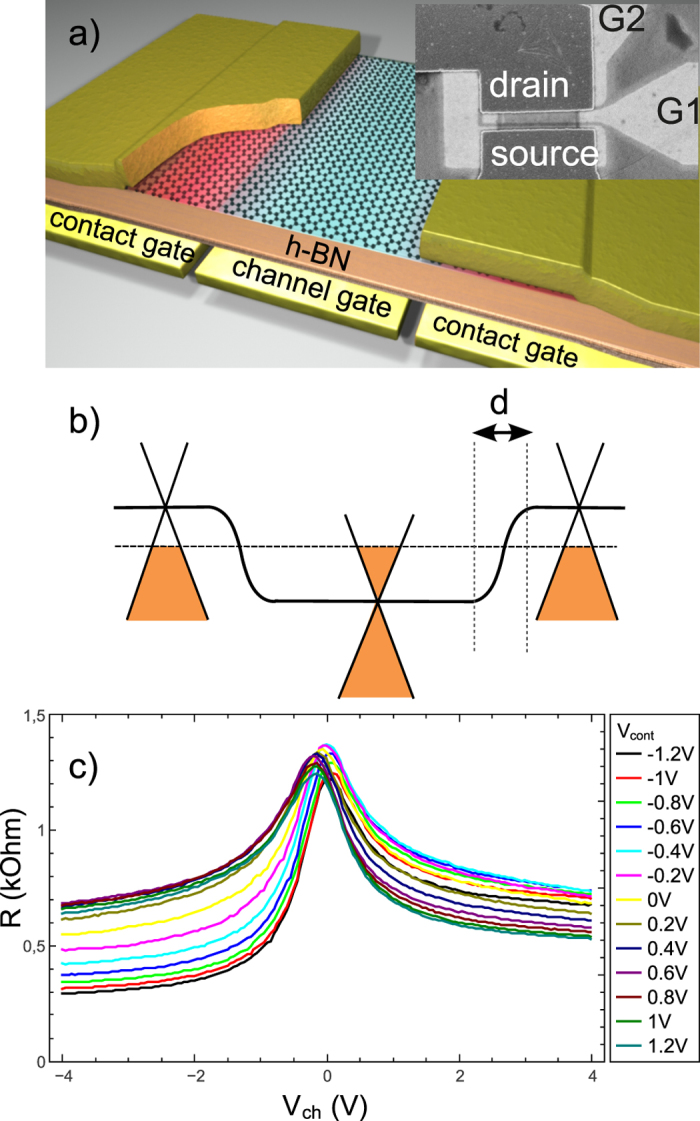
Panel (a): artist view of the contact-gated graphene transistor achieving independent channel and contact gating. Inset: SEM image of the transistor; here G1 and G2 stand for channel and contact gates respectively. The scale is given by the channel width and length of 1.1 μm and 0.2 μm respectively. Panel (b): sketch of the doping profile of the device. Panel (c): Dependence of the resistance transfer function by the contact-gate voltage. Characteristic features of independent contact and channel gating are prominent: i.e. a strong modulation in the p and n doped regimes and the absence of modulation of the Dirac peak position.